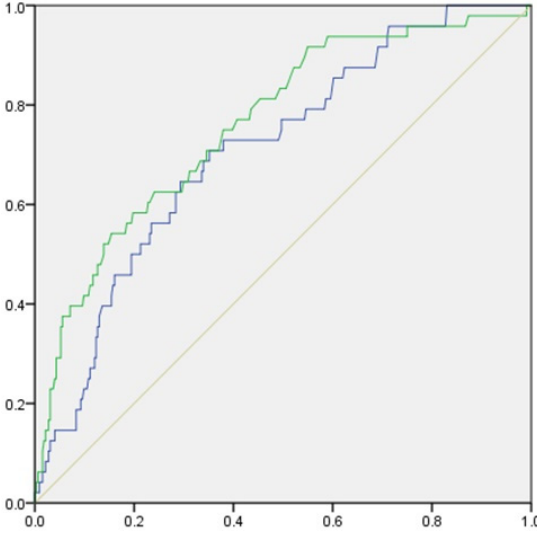
Figure 2. ROC curve of effective factors for screening for type 2 diabetes. The green line represents alveolar bone loss; the blue line represents high-sensitivity C-reactive protein value.